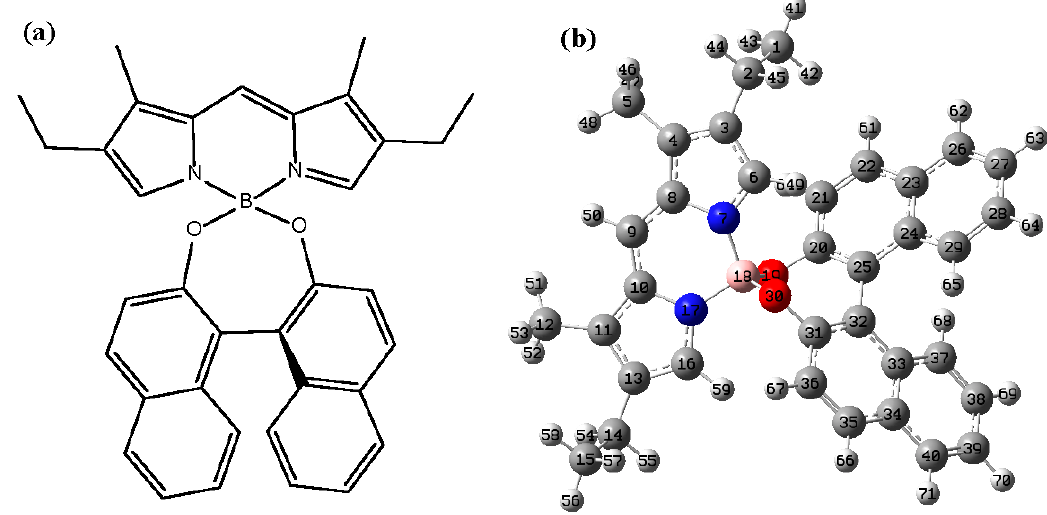
Figure 1. The Lewis formula ( a ) and 3D molecular structure ( b ) of PM567 dye.